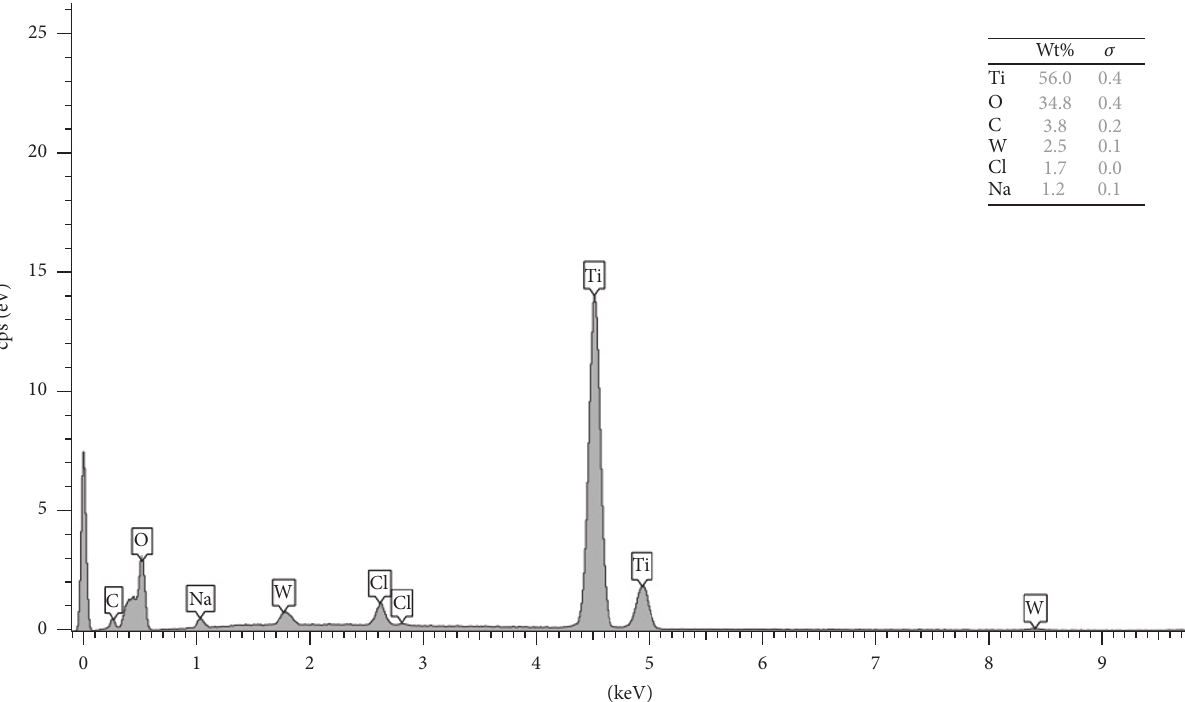
Figure 2: EDS spectrum image 1% WO 3 -doped TiO 2 coated